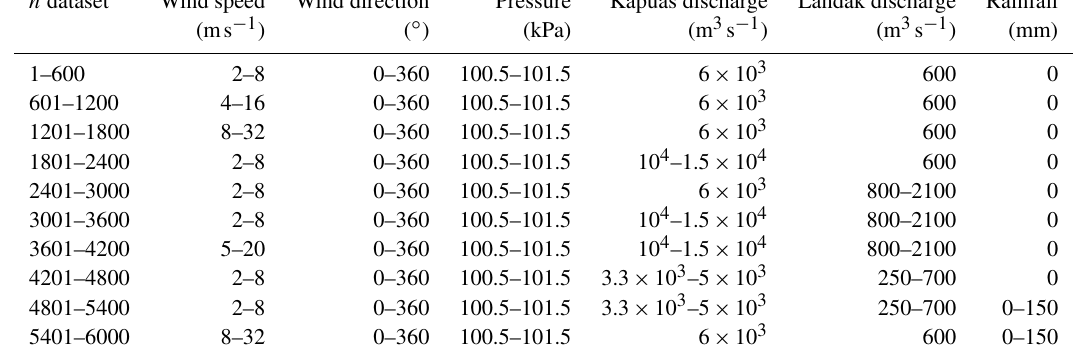
Table 1. Scenarios used to force the process-based hydrodynamic model. n dataset